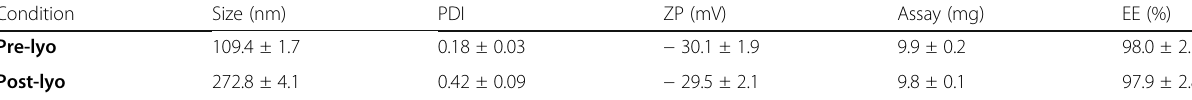
Table 3 Physicochemical characteristics of optimized ZT-SLN before and after lyophilization (mean ± SD, n = 3) Condition